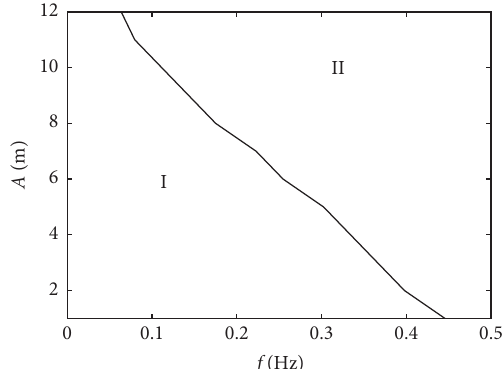
Figure 16: Excitation amplitude and frequency region where re- laxation tension phenomenon can